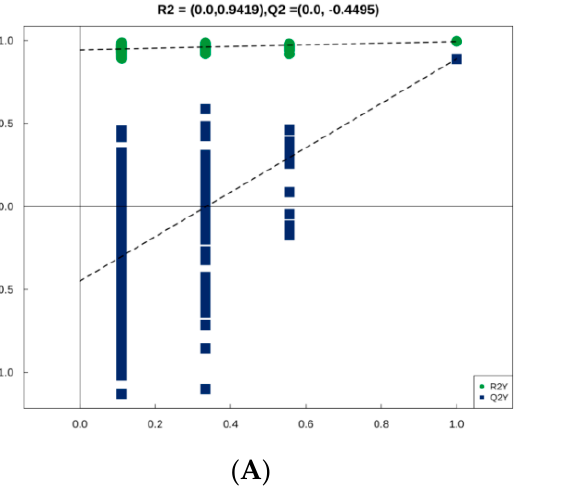
Figure 2. OPLS-DA model. Two hundred rounds of permutation testing were done per component. p < 0.05 was used for statistical analysis. ( A ) Positive ion mode; ( B ) Negative ion mode.